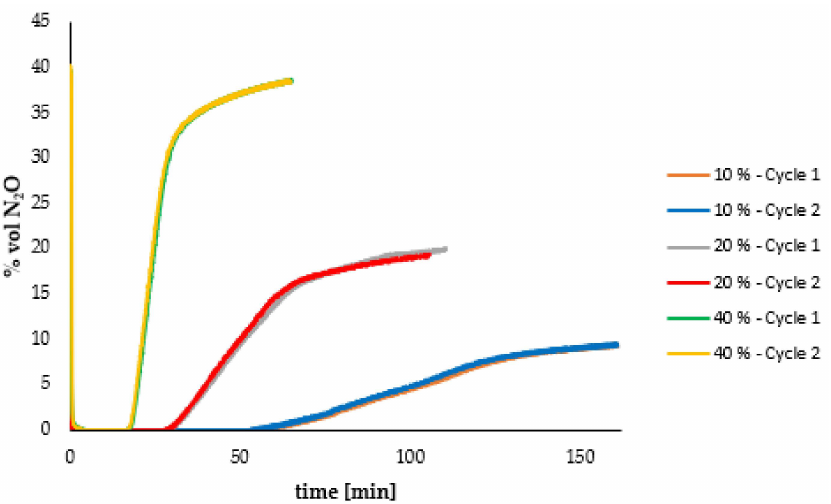
Figure 4. Breakthrough comparison diagram for two consecutive adsorption–desorption cycles at N 2 O partial pressure of 10% vol, 20% vol, and 40%